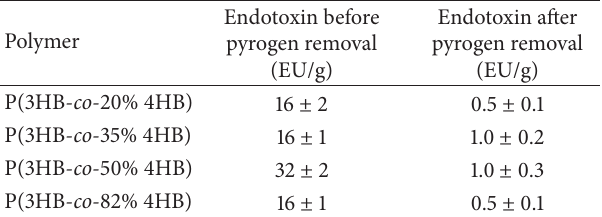
Table 1: Endotoxin levels present in the P(3HB- co -4HB) scaffolds recovered by the chloroform extraction method before and after pyrogen removal.